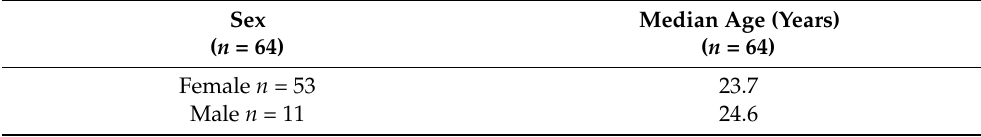
Table 2. Demographic structure of the respondents in the pharmaceutical care